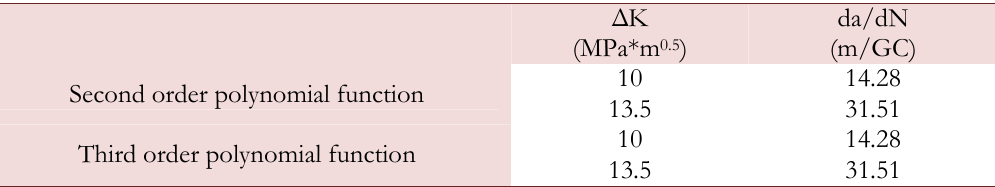
Table 6: Crack growth rates computed using the procedure